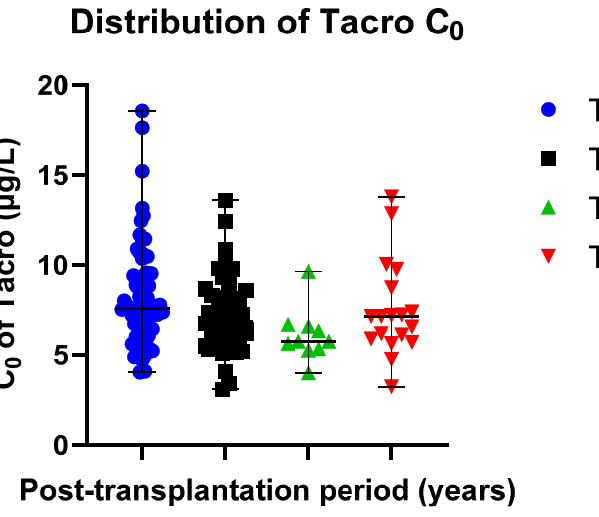
Figure 3. Distribution of Tacro C 0 values in the study groups: Tacro + MMF and Tacro monotherapy; MMF—mycophenolate mofetil; Tacro—tacrolimus. Scatter plots display the individual C 0 values’